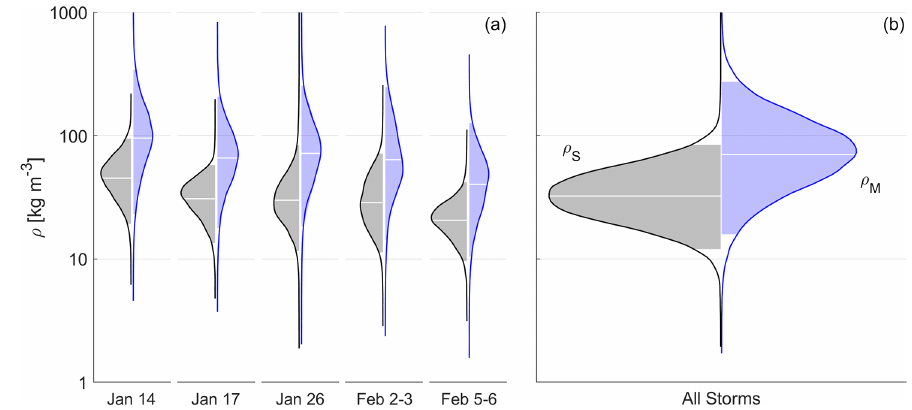
Figure 6. Linear probability density functions of snow density measurements using the spherical volume assumption (gray) and the MASC- adjusted volume (blue) separated into individual storms (a) and for all snowflakes (b) . Mean values and ± 2 σ values are represented by white horizontal lines and the boundary between shading and white space under the tails of the curves.